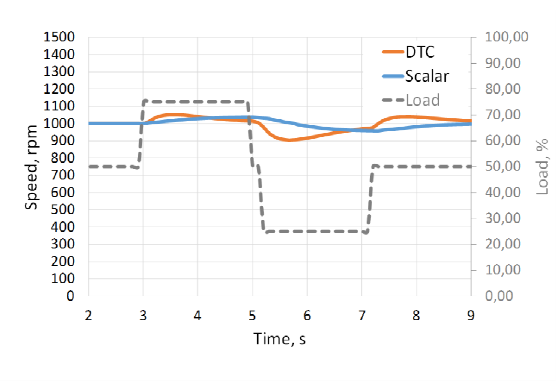
Fig. 10. Drive speed response on variable load of meander profile.